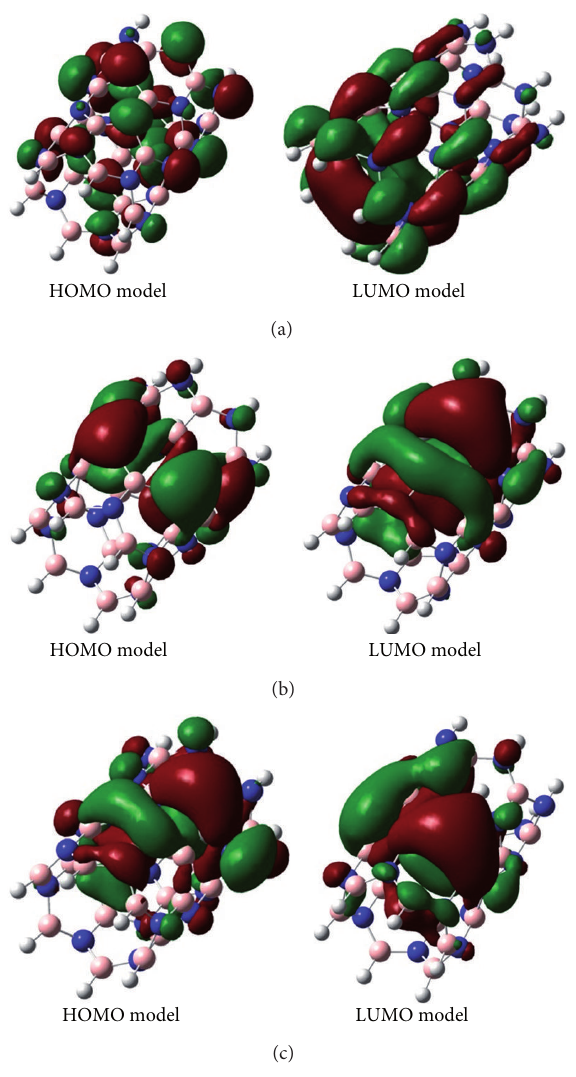
F 5: HOMO and LUMO orbitals for different models of the BNNTs; (a) pure model, (b) and (c) diborinin-doped